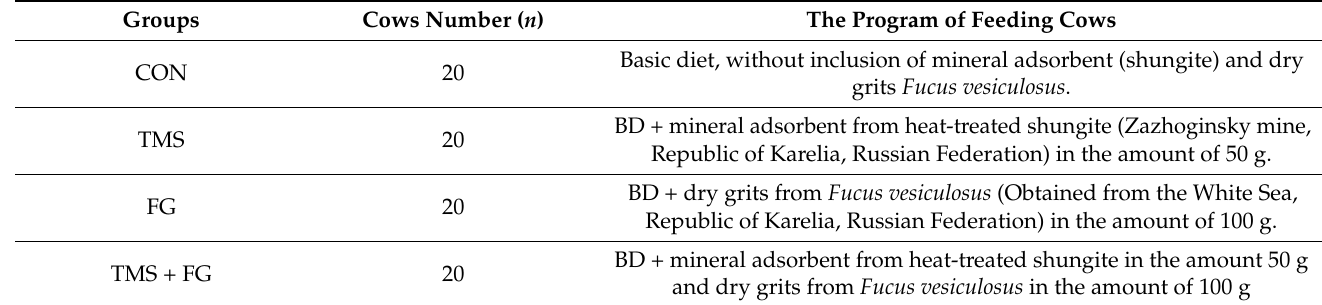
Table 1. Feeding scheme and research